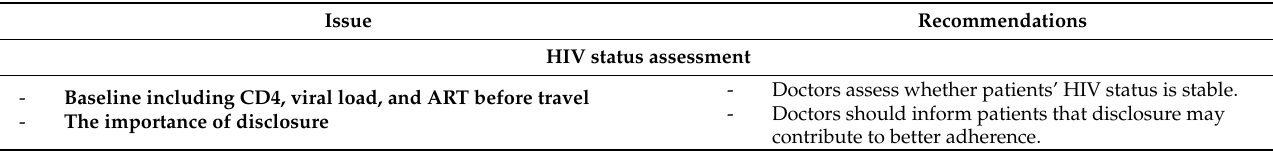
Table 5. Authors’ proposed pretravel consultation